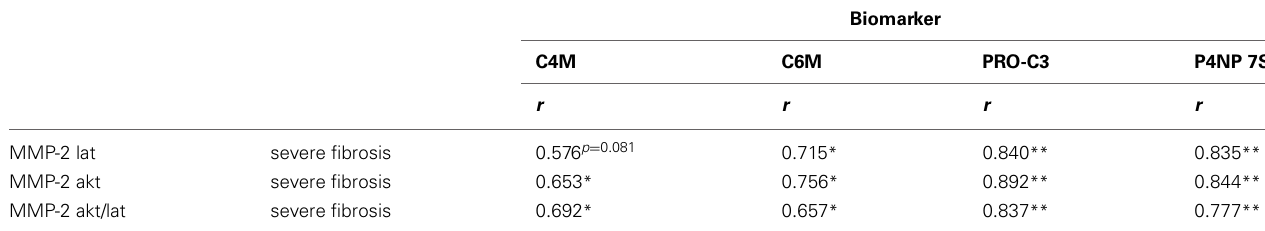
Table 5 | Correlation of ECM turnover with ECM